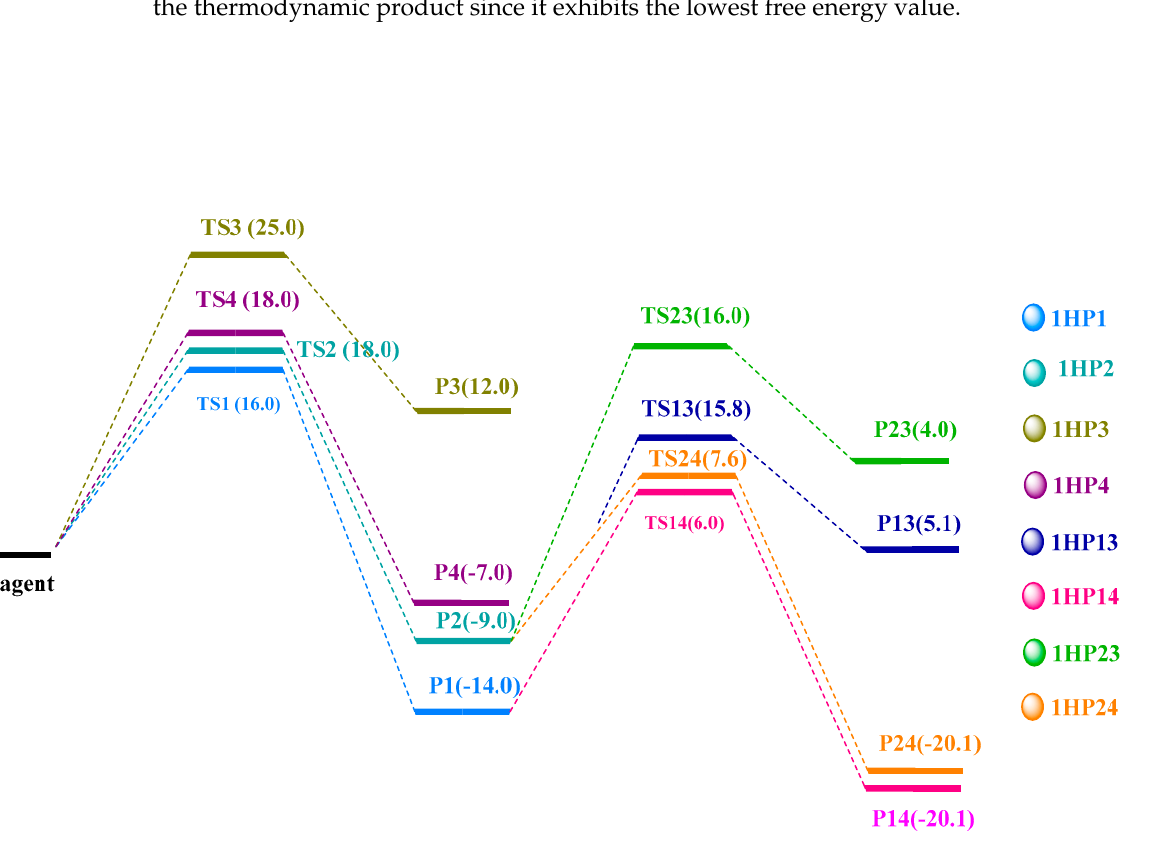
Figure 6. Energy diagram of the full path reaction from the reagent to the final desired products. The effects of halogen, multi-fluorine and the nature of DP(C=C or C=O) on 𝐸 (cid:3028) and Δ 𝐸 (cid:3045) values and, consequently on the kinetic and thermodynamic profiles were investi- gated. The obtained results are presented in the Tables 2 and 3. The four TSs(TS1HP1-4) including all the standard data required in computational works are included in the Sup- porting Materials.